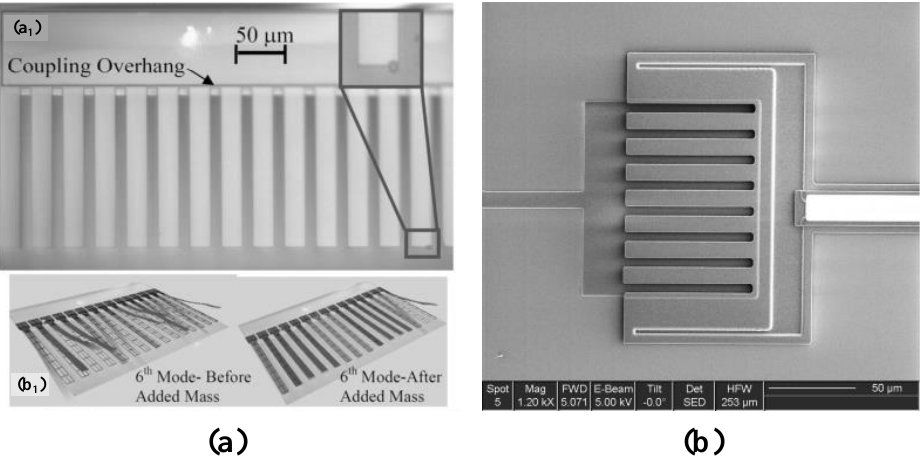
Figure 11. SEM photo of ( a ) weakly coupled ME-SCRB with cantilever array. Reproduced with permission from [57]. Rights managed by AIP Publishing. ( b ) Strongly coupled ME-SCRB with cantilever array. Reproduced with permission from [55]. Copyright © 2014 by M.Sadegh Hajhashemi. The comparisons of the properties of different ME-SCRB sensors are listed in Table